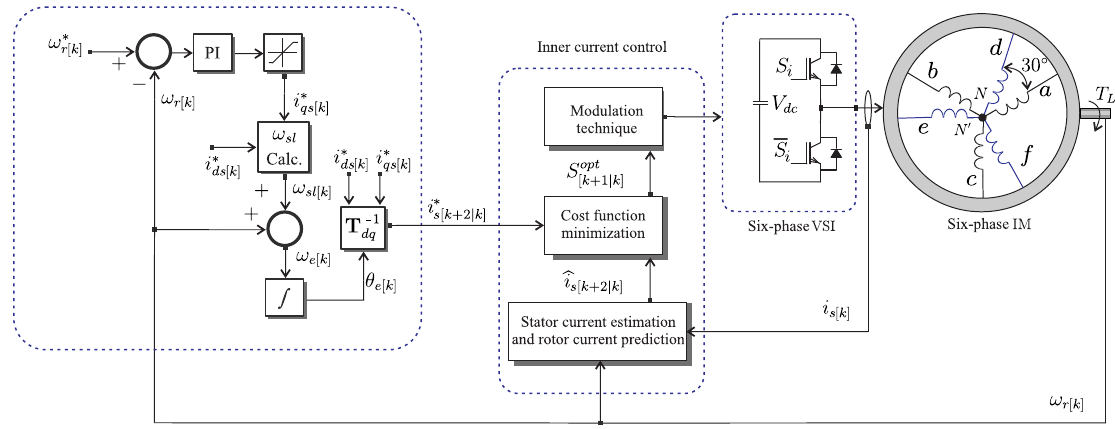
Figure 3. Complete diagram of the PFSCCS applied to six-phase